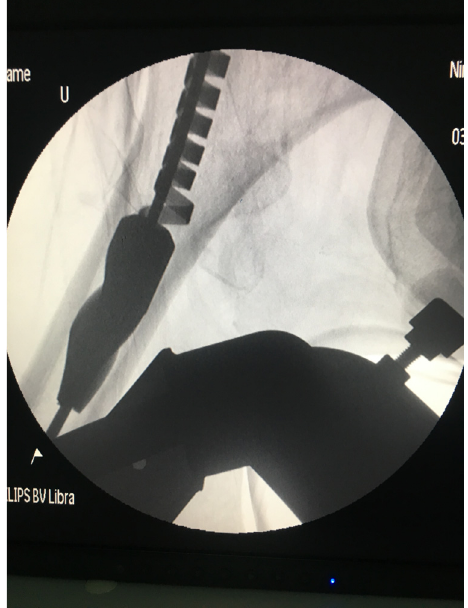
Figure 2. The reamer head was broken, then ruptured completely fi nally, and remained in femoral shaft isolated, it can ’ t pull out just rely on hauling.